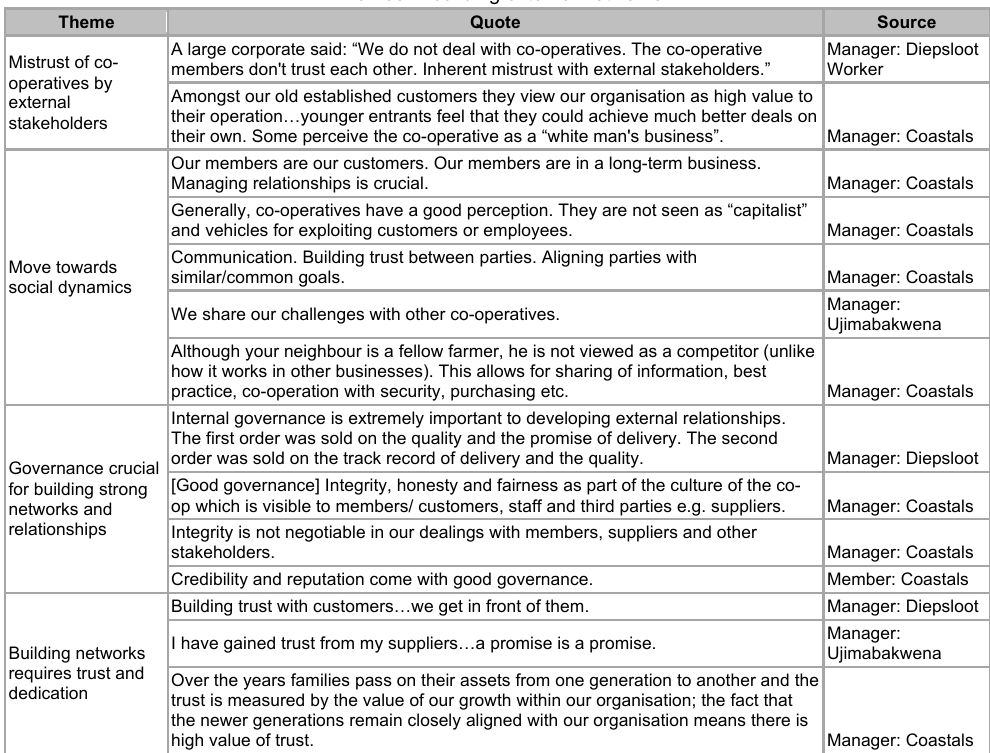
Themes in building external